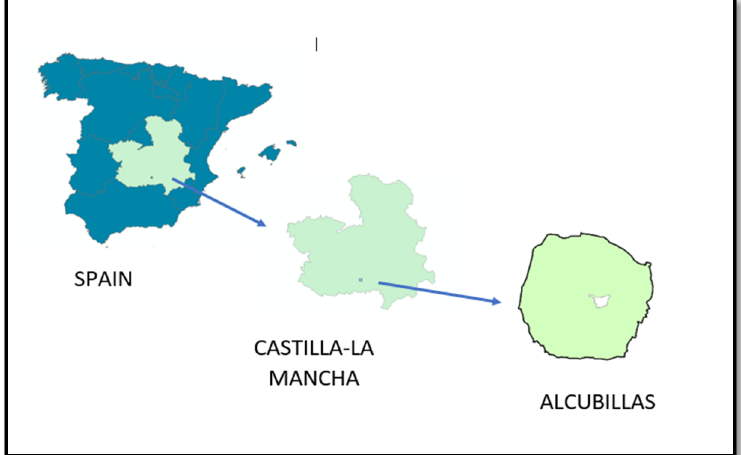
Figure 1. Geographical location of the study area.